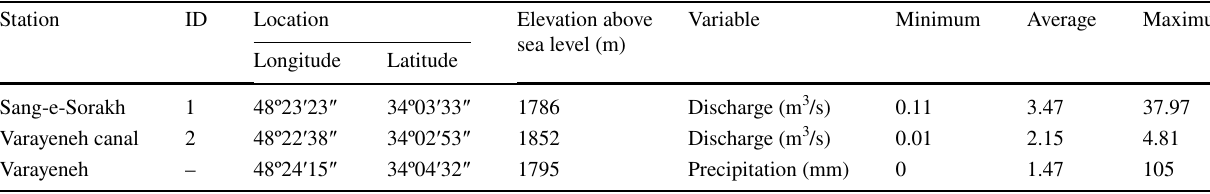
Table 1 Daily parameters in the stations used Station ID Location Elevation above